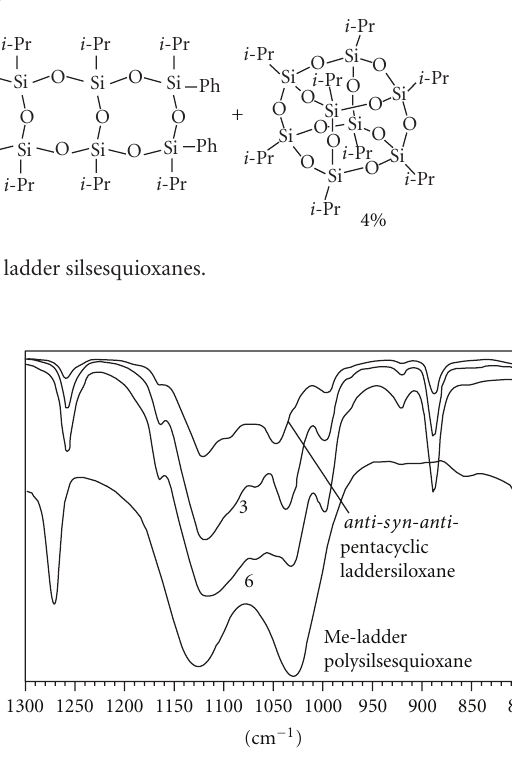
Figure 2: IR spectra of pentacyclic, heptacyclic, nonacyclic ladder- siloxanes and ladder